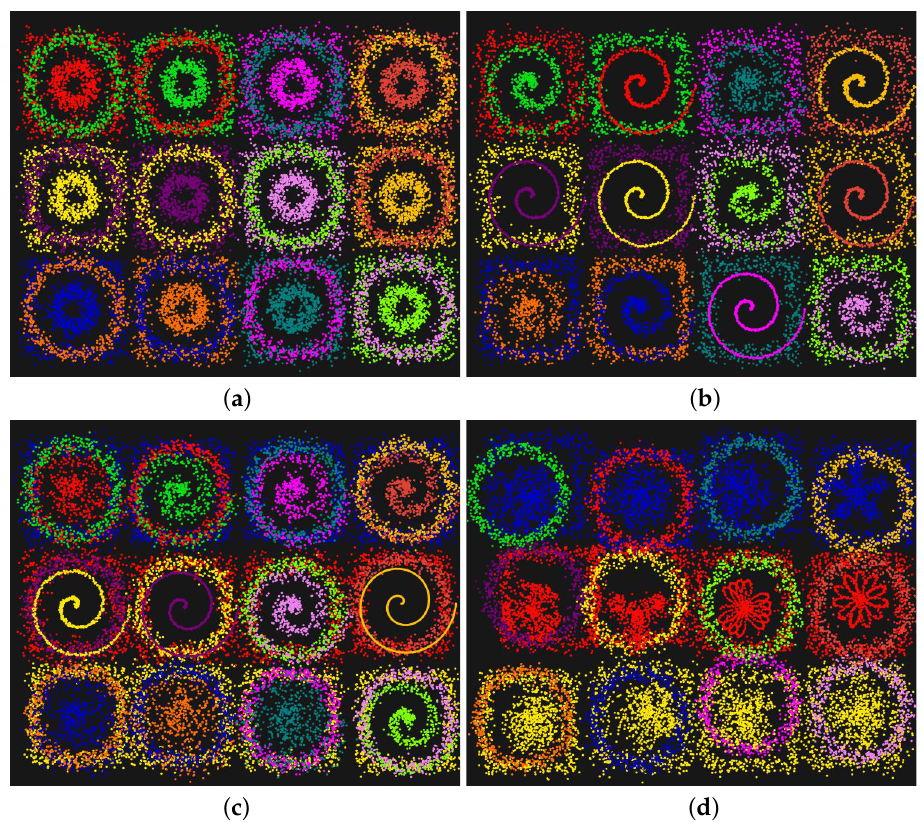
Figure 3. Four different stigmergic color-symmetric patterns with reminiscence of Kandinsky’s color study in Figure 1a. ( a ) Vertical reflection imposing a color symmetry of circles and squares from primary and secondary colors to tertiary colors. ( b ) Vertical reflection imposing a color symmetry of Archimedean spirals and squares from primary and secondary colors to tertiary colors. ( c ) Color reversed version of ( b ). ( d ) Vertical reflection imposing a color symmetry of circles and squares which preserve primary colors and change secondary colors to tertiary